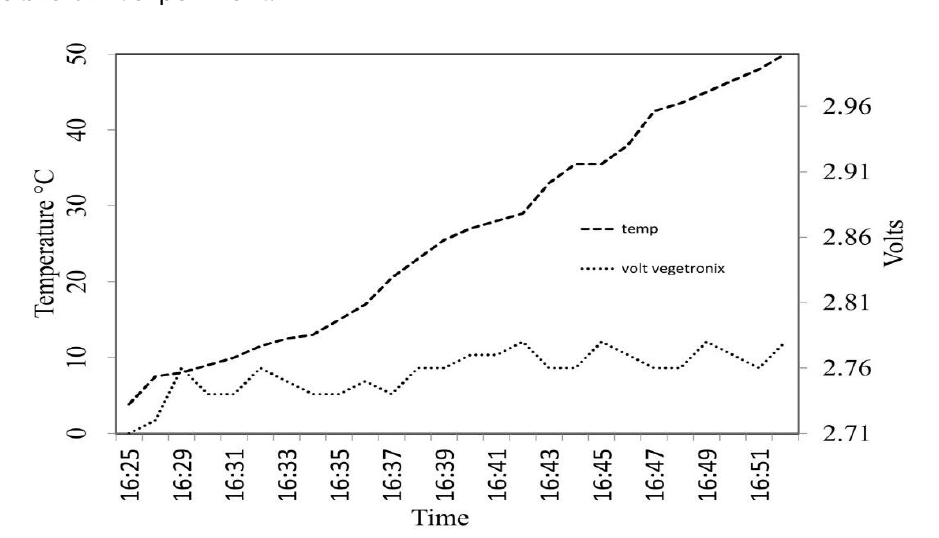
Figure 5. Variation of temperature and dielectric probe readings in water during the temperature-drift